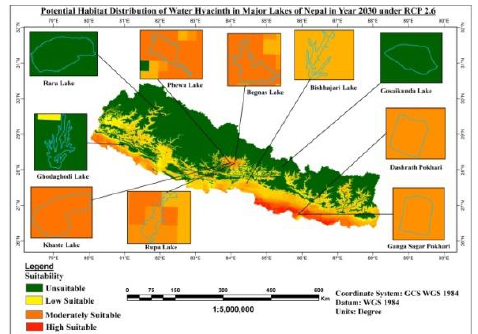
Figure 11. Potential Habitat Distribution of Water Hyacinth in the lakes of Nepal in year 2050 under RCP